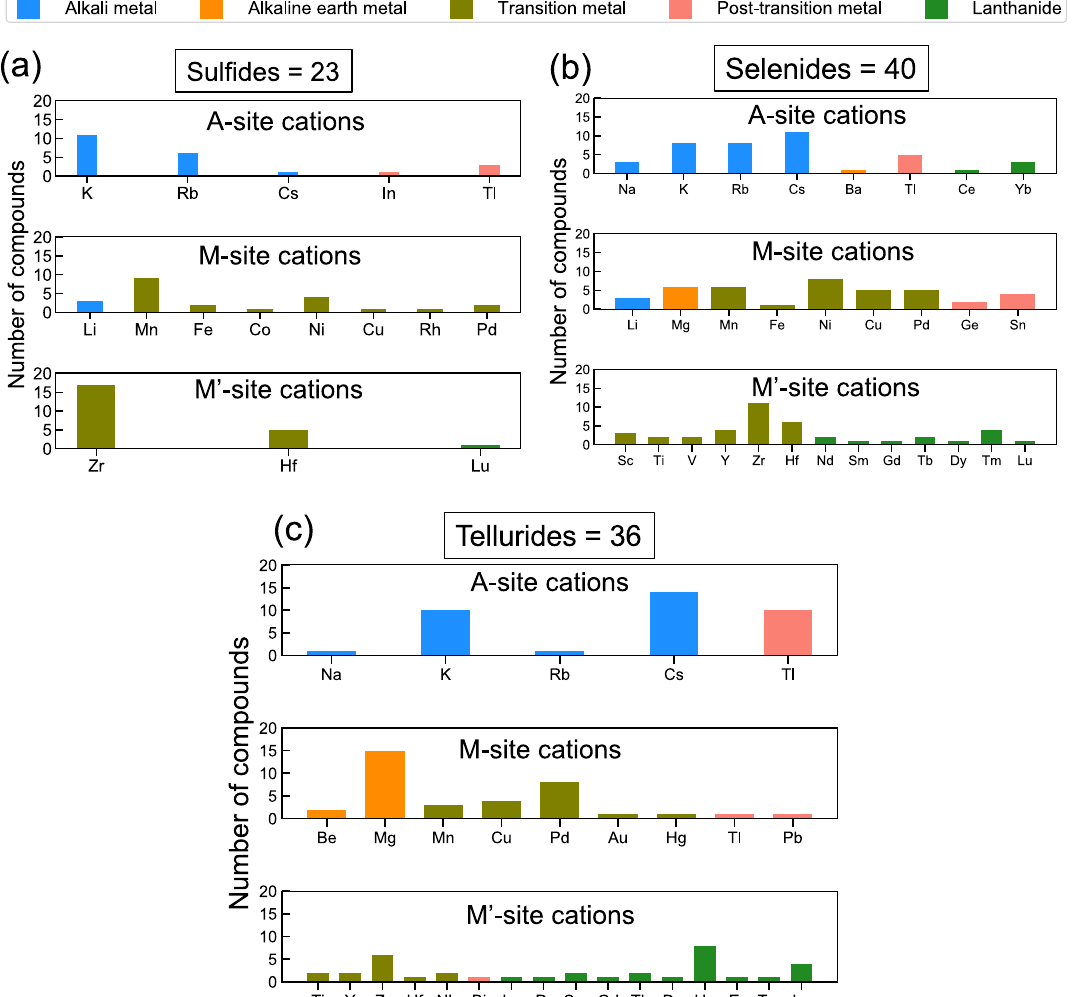
Fig. 4 Elemental distributions of the predicted stable compounds. The cations occupying the A-, M-, and M ′ -sites in the predicted stable quaternary chalcogenides are shown as bar charts. The height of each bar represents the number of stable compounds that contain the element. There are a total number of 99 predicted stable compounds that consist of a 23 sul fi des, b 40 selenides, and c 36